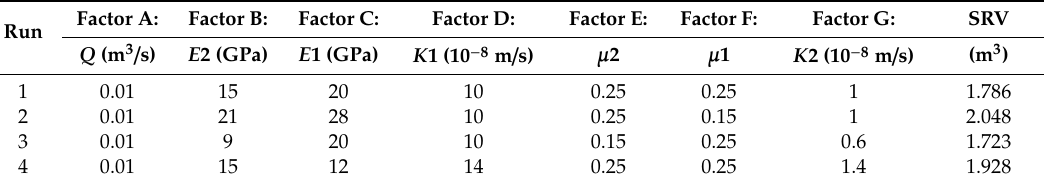
Table 3. The results of the Box–Behnken